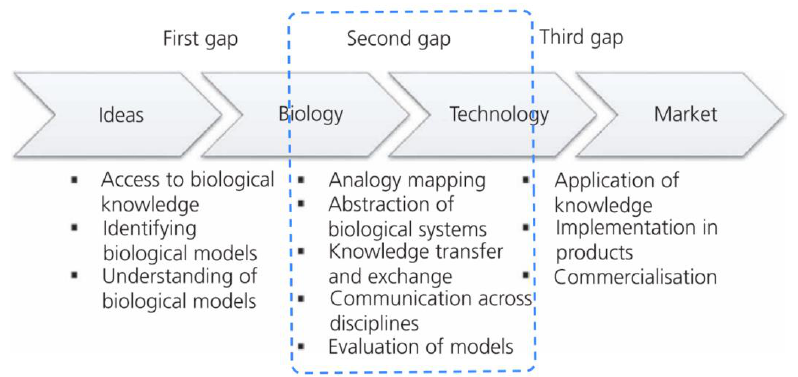
Figure 1. ‘Gaps’ (or conceptual leaps) in the biomimicry design process and their underlying Figure 1. ‘ Gaps ’ (or conceptual leaps) in the biomimicry design process and their underlying challenges [27] with the ‘second gap’ outlined to indicate the area of focus for this challenges [27] with the ‘ s econd gap’ outlined to indicate the area of focus for this study .